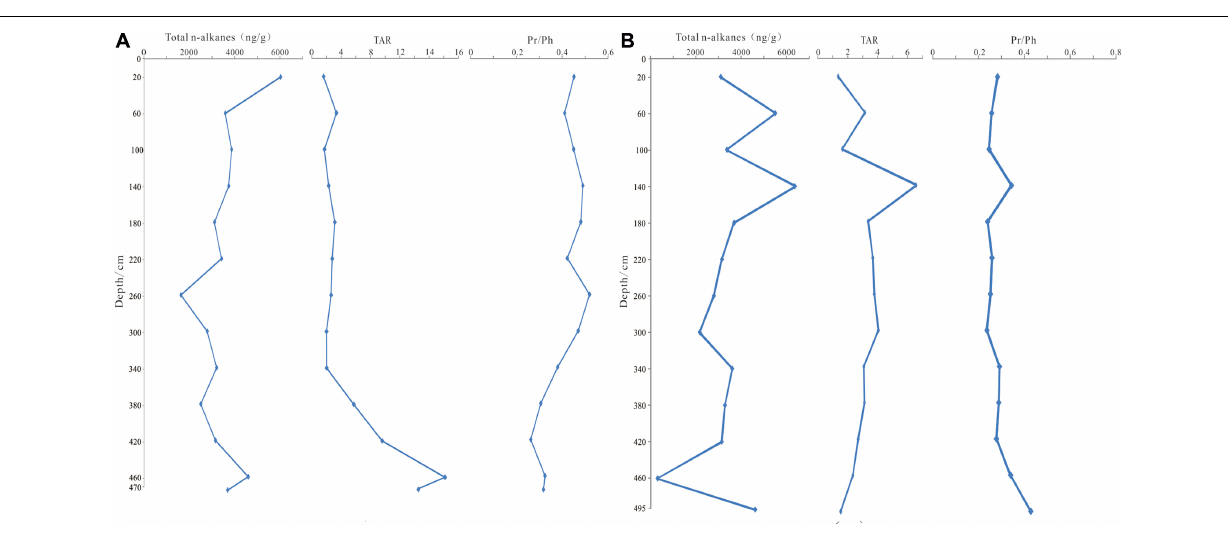
FIGURE 5 | Vertical profiles of the typical molecular compositional patterns of core (A,B) .